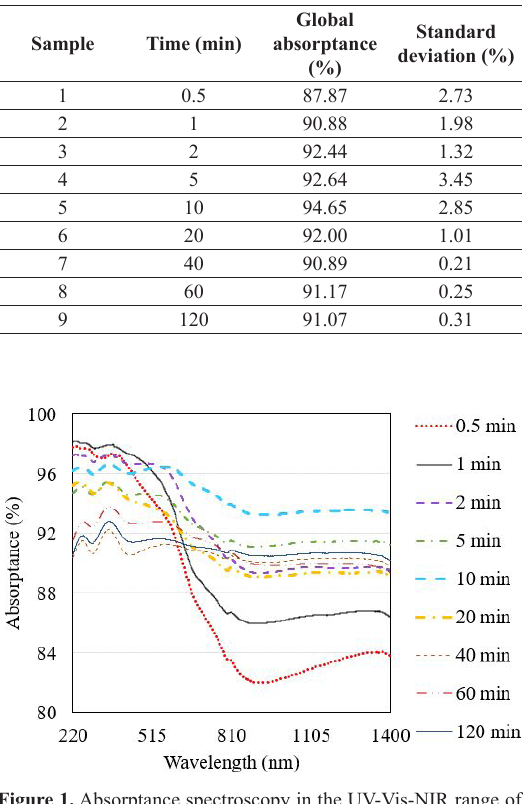
Figure 3. FTIR Spectroscopy.